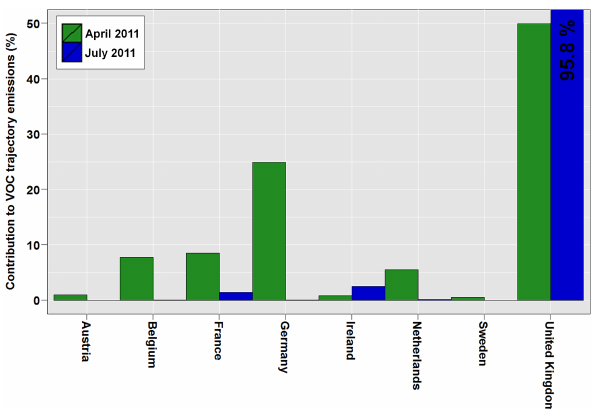
Figure 13. Contributions to the average VOC 96h back-trajectory emission estimates in April 2011 (green bars) and July 2011 (blue bars) from countries which contributed at least 0.5% during one of the months. The contribution of the UK in July 2011 was 95.8% and has been truncated in the